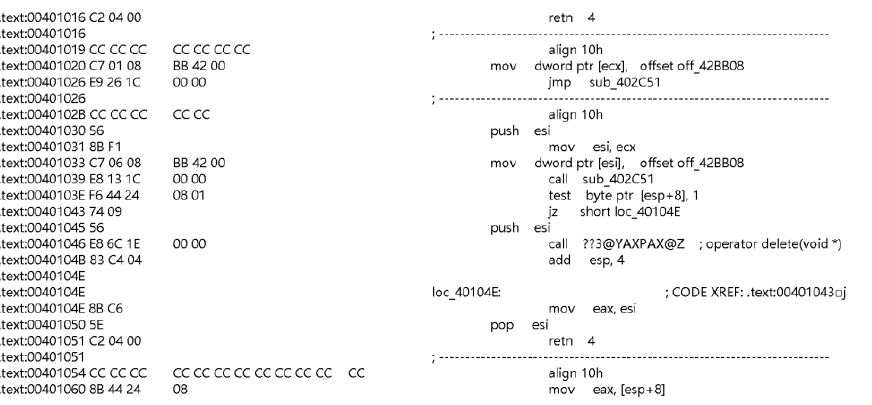
Figure 5. Malware detection model structure.